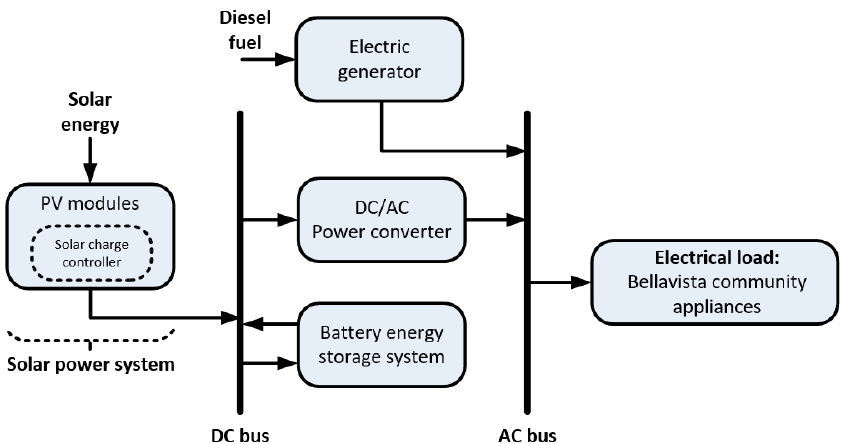
Figure 4. Design configuration of the off-grid hybrid power system (OHPS) in the Bellavista community.